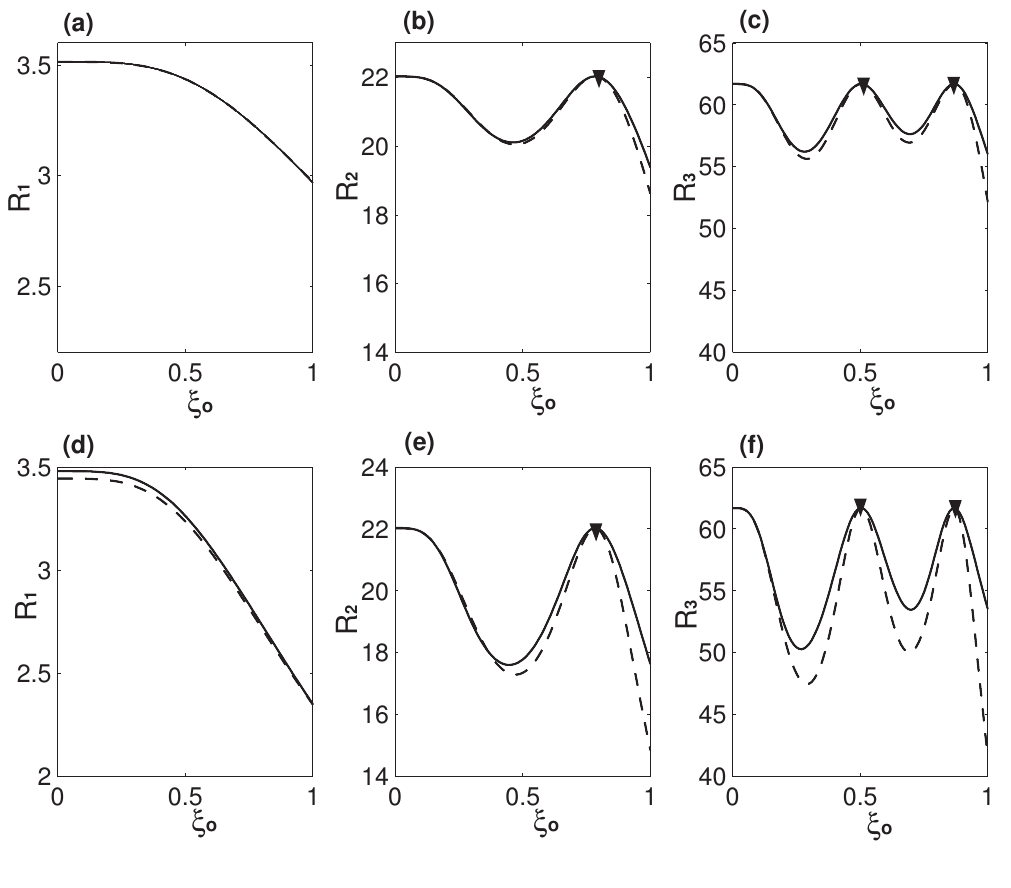
Figure 2. ( a – c ) The first, second and third eigenfrequencies with α = 0 . 1 and C = 0 . 1 , respectively; ( d – f ) the first, second and third eigenfrequencies with α = 0 . 3 and C = 1 , respectively. The solid lines are the results obtained by Equation (8), and dashed lines are those obtained by Equation (11). The solid triangles indicate the